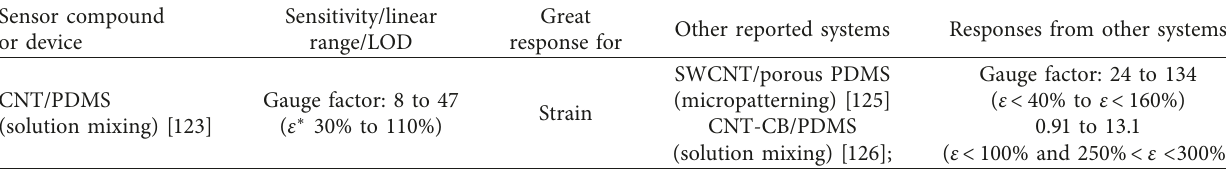
Table 4: Comparison between a strain sensor system described in this review and a different system found in the literature. Sensor compound or device